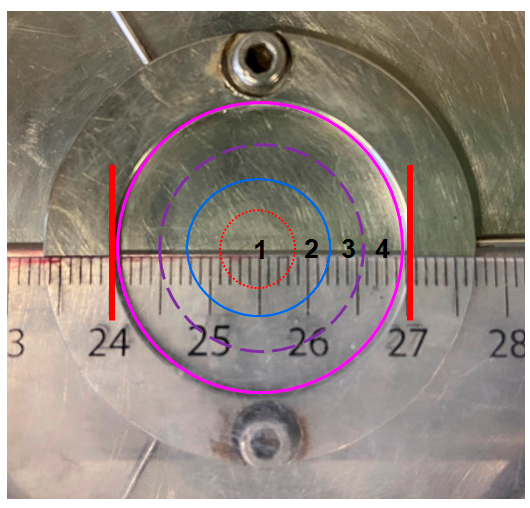
Figure 12. Four divided sections of the lower plate.